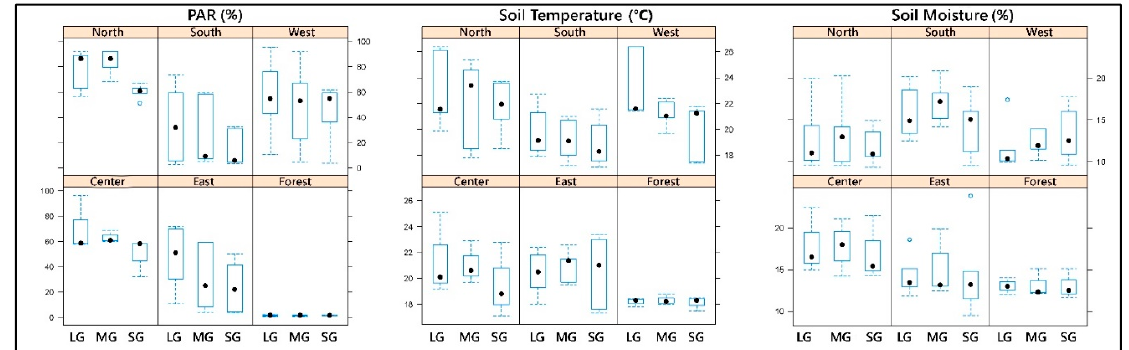
Figure 2. Median values and related variability of Photosynthetically active radiation (PAR), Soil temperature and Soil moisture in each gap size for each cardinal point and in forest. LG, large gap; MG, medium gap; SG, small gap. The solid dot indicates the median values. In the box, the lower limit corresponds to the value of the first quartile (Q1) of the distribution and the upper limit to the third quartile (Q3); the vertical lines (whiskers) delimit the intervals in which the lower values of Q1 (in the lower part) and the greater values of Q2 (in the upper part) are positioned. Outliers are reported as empty dots.